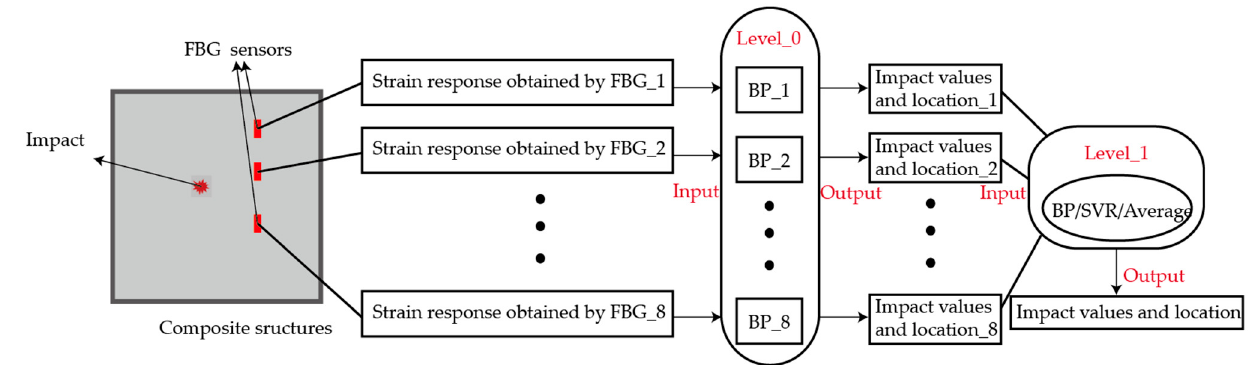
6 of 20 Figure 4. Stacking-based ensemble model for input data processing of level-0. In the stacking-based ensemble learning method, when the impact occurs on the composite structures, the strain response could be recorded by FBG sensors. The impacts and their corresponding strain responses are generally divided into a training set and a test set. For a certain base learner model from level-0, cross validation is used on the training set, meaning that 80% of the data are used for training and 20% for testing. Then, the trained base learner model is also used to predict the test set. This process is repeated five times. The identification results from the training set is taken as a new training set,